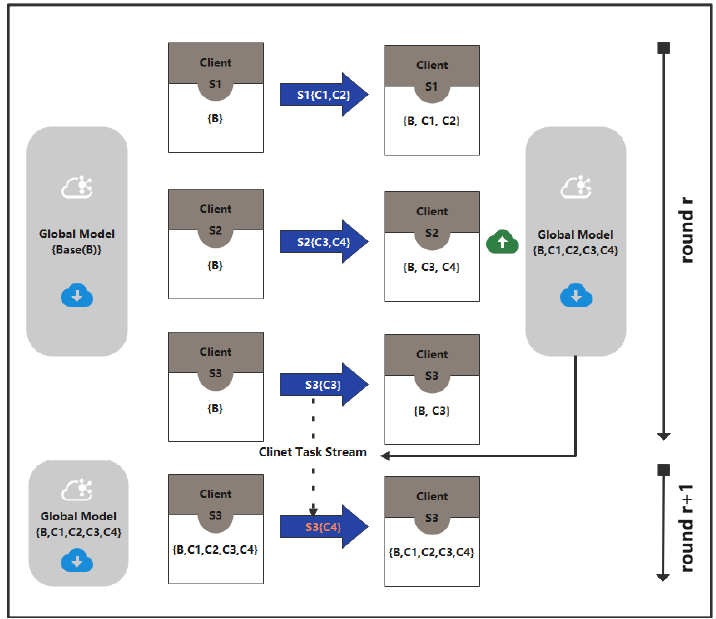
Figure 3. Description of the